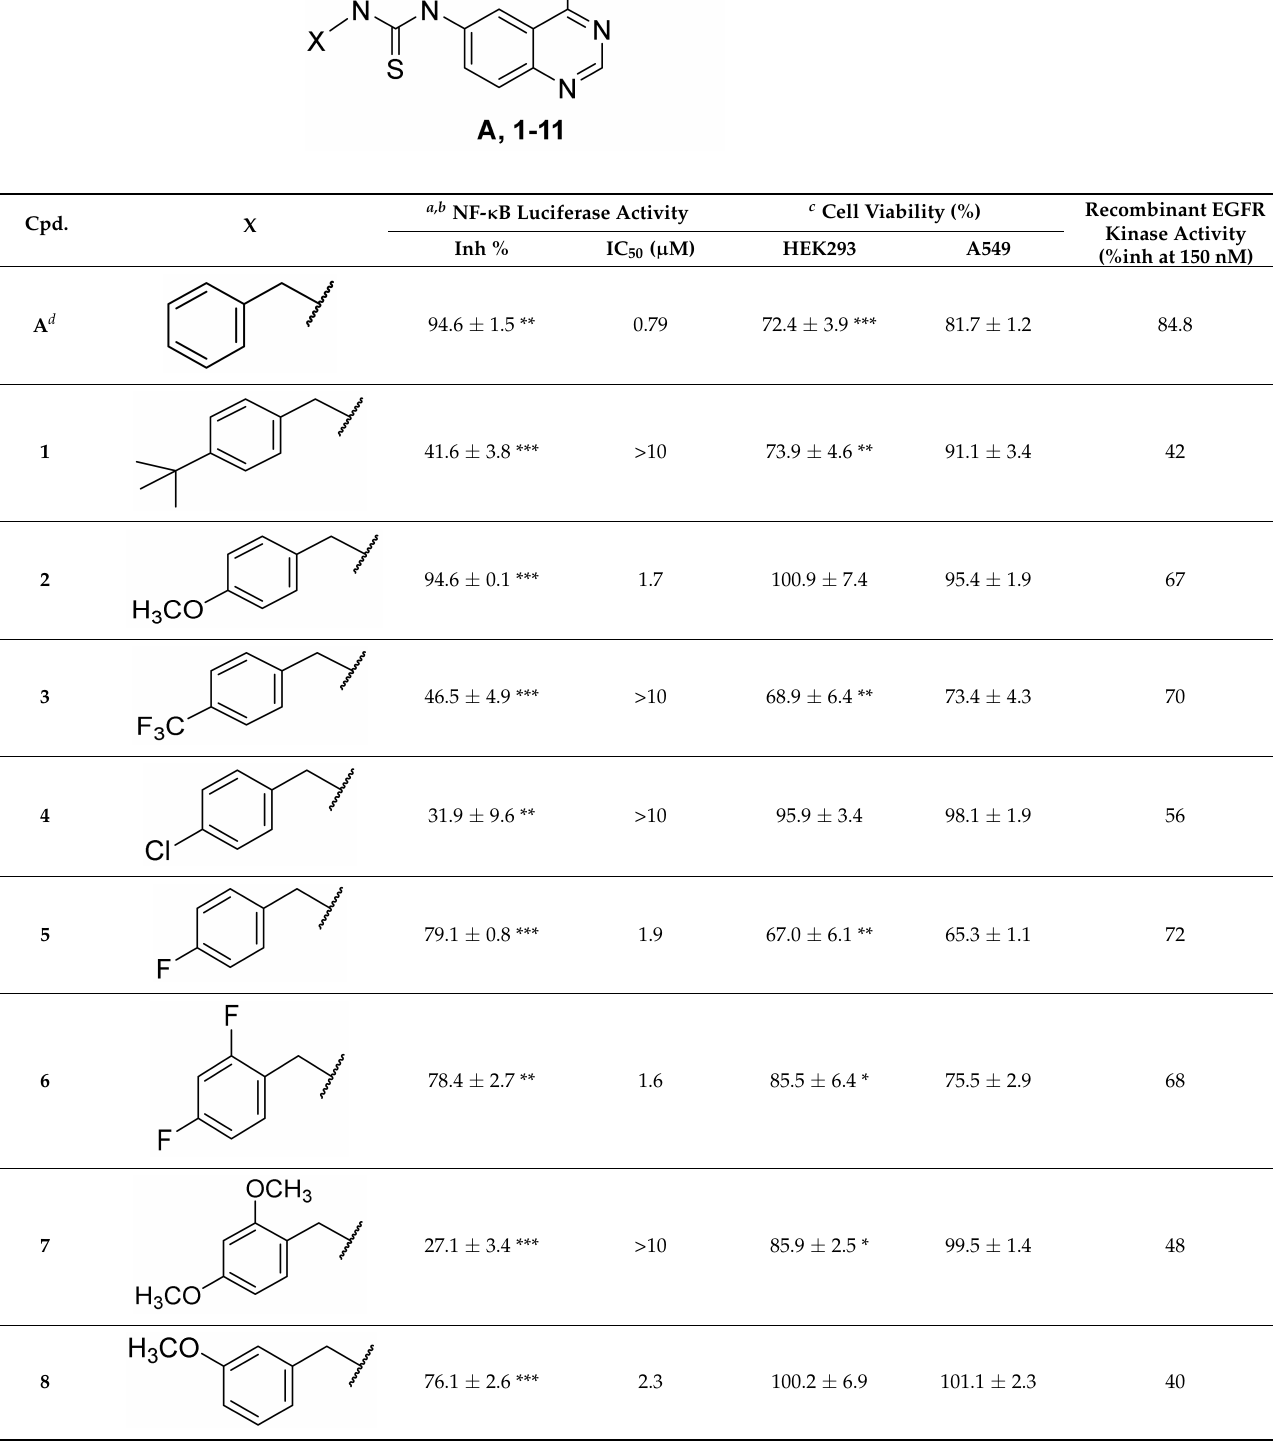
Table 1. Biological activities of NF- κ B inhibitors with benzylthioureido and analogous moieties.